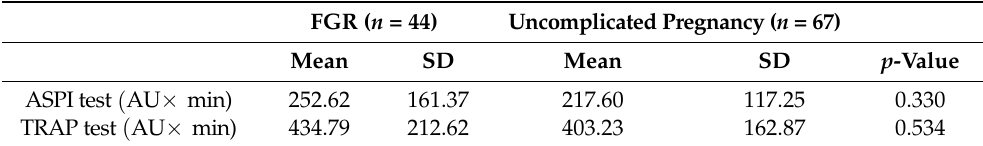
Table 3. Results of ASPI and TRAP tests in the studied